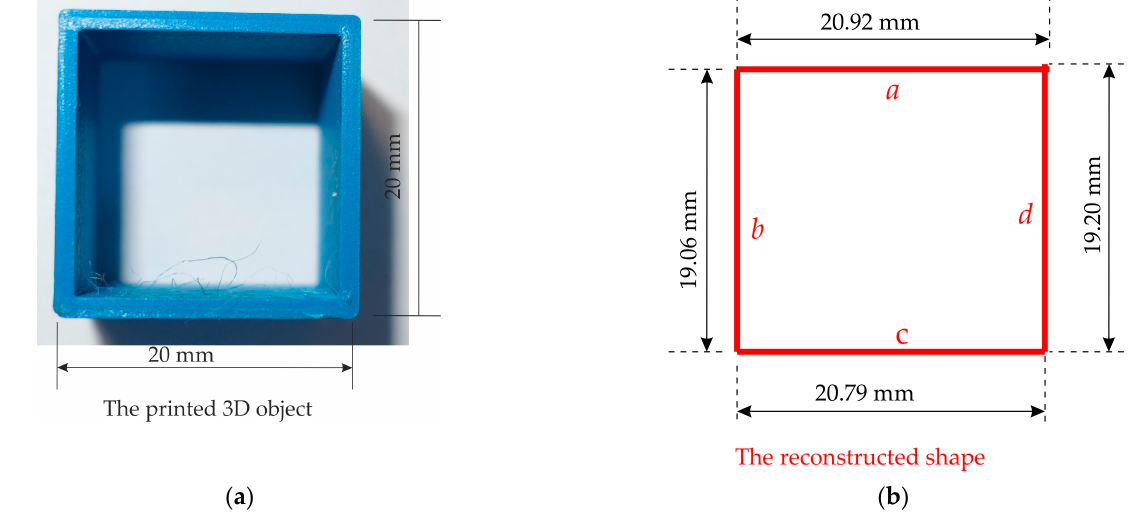
Figure 15. The reproduced object in the form of a tetrahedron: ( a ) a real shape, ( b ) reconstructed shape.